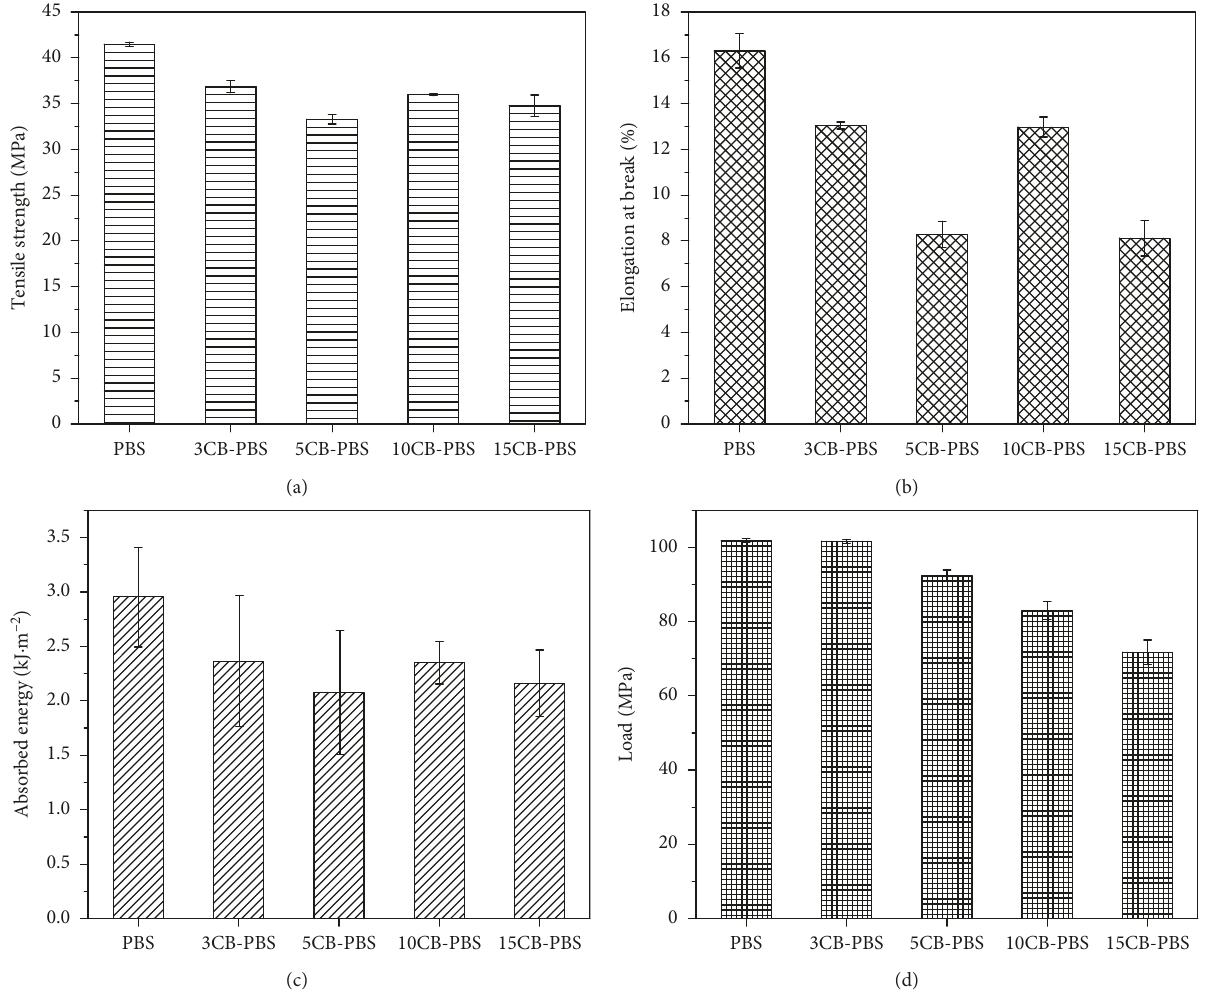
Figure 6: (a) Tensile strength, (b) elongation at break, (c) impact strength, and (d) bending strength of the pristine PBS as well as the xCB- PBS composite